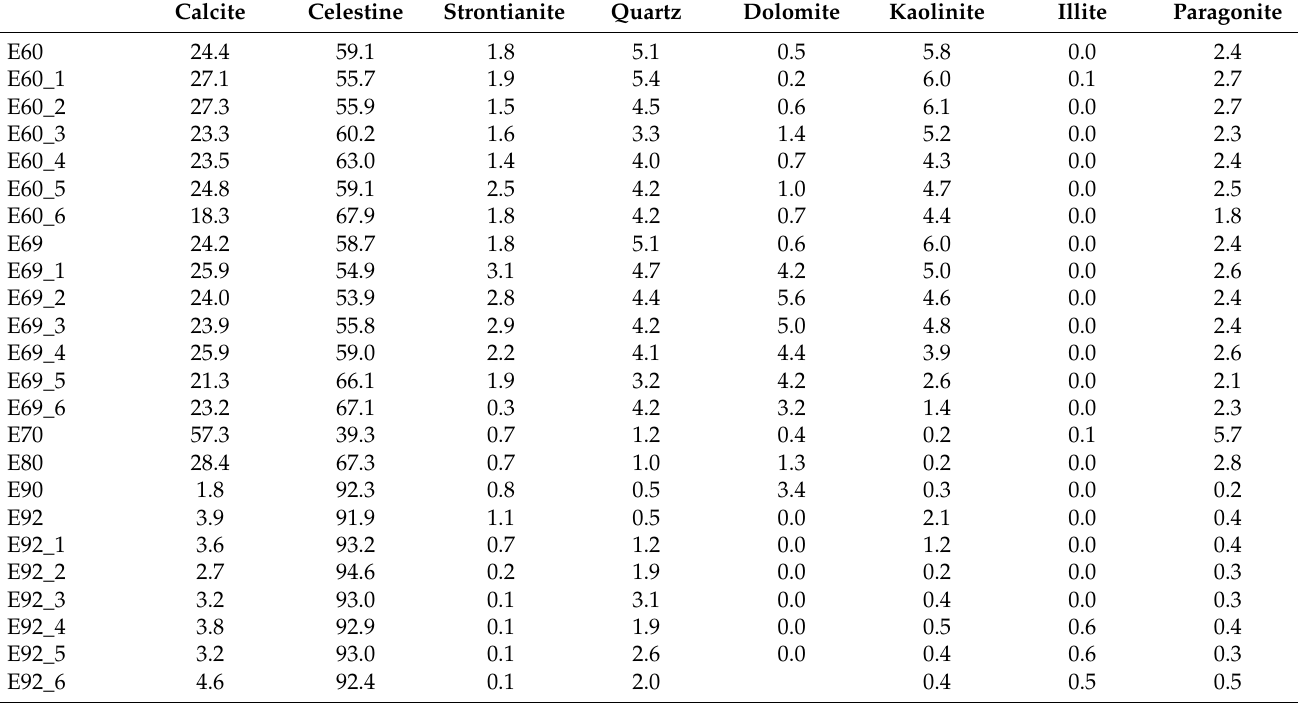
Table 4. Quantitative mineral composition of samples determined by X-ray diffraction Rietveld